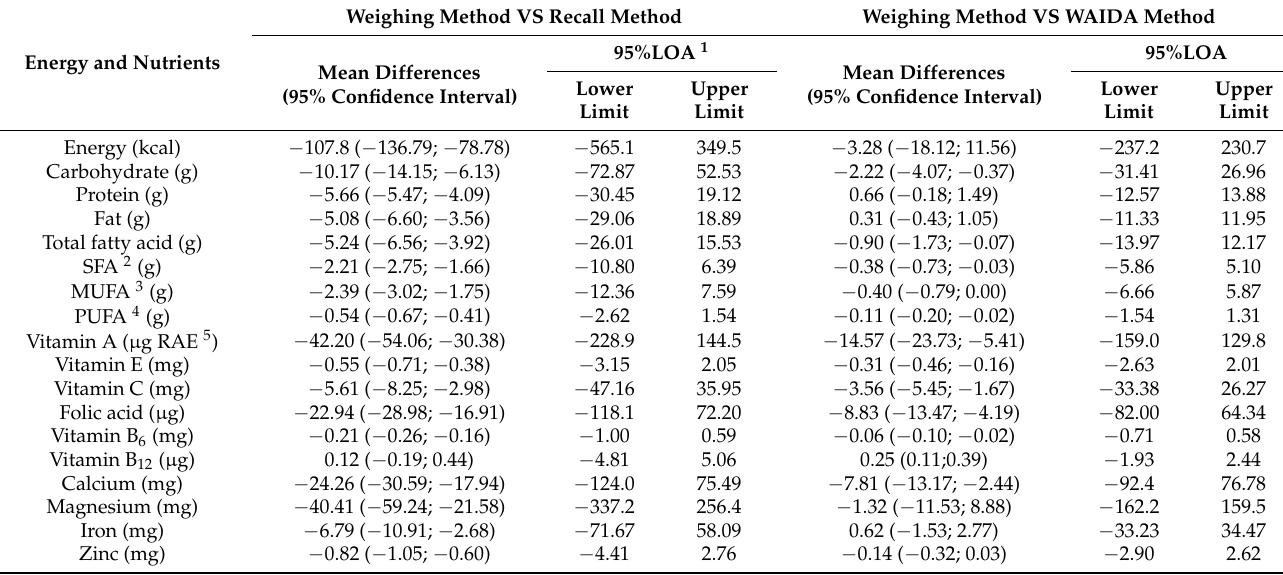
Table 5. Bland-Altman analyses of energy and nutrient intakes estimated by the weighing method and those estimated by the recall or WAIDA method ( n = 251